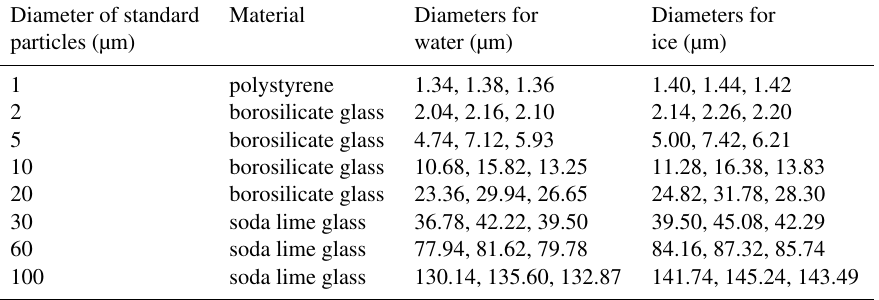
Table A2. Conversion of the diameter of standard spherical particles to those of spherical water droplets and hypothetical spherical ice particles. In the third and fourth columns, the minimum, maximum, and the average of the two are shown in each table element.